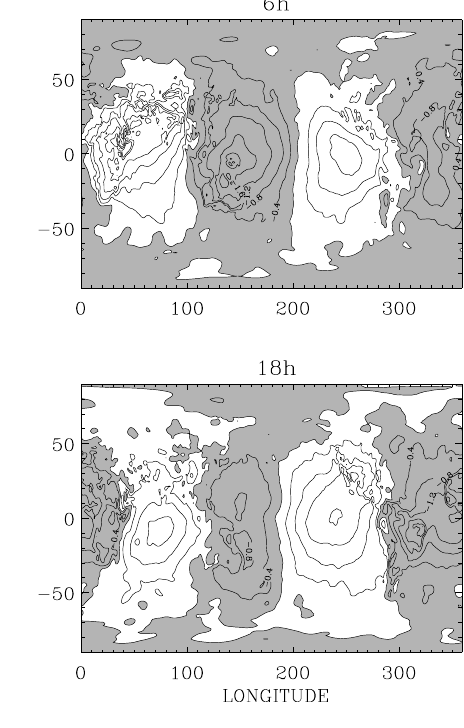
Fig. 2. As in Fig. 1 but showing climatological daily cycle for